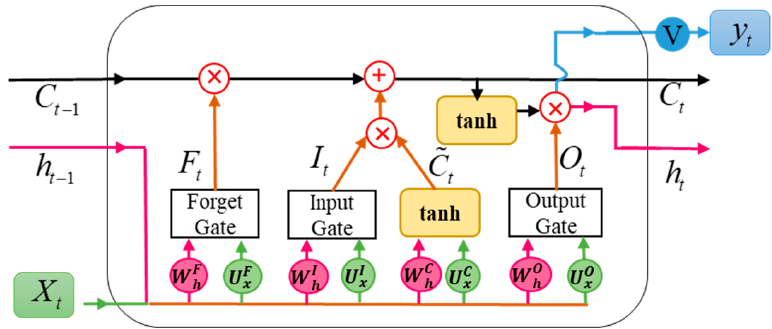
Figure 9. The structure of the LSTM unit.